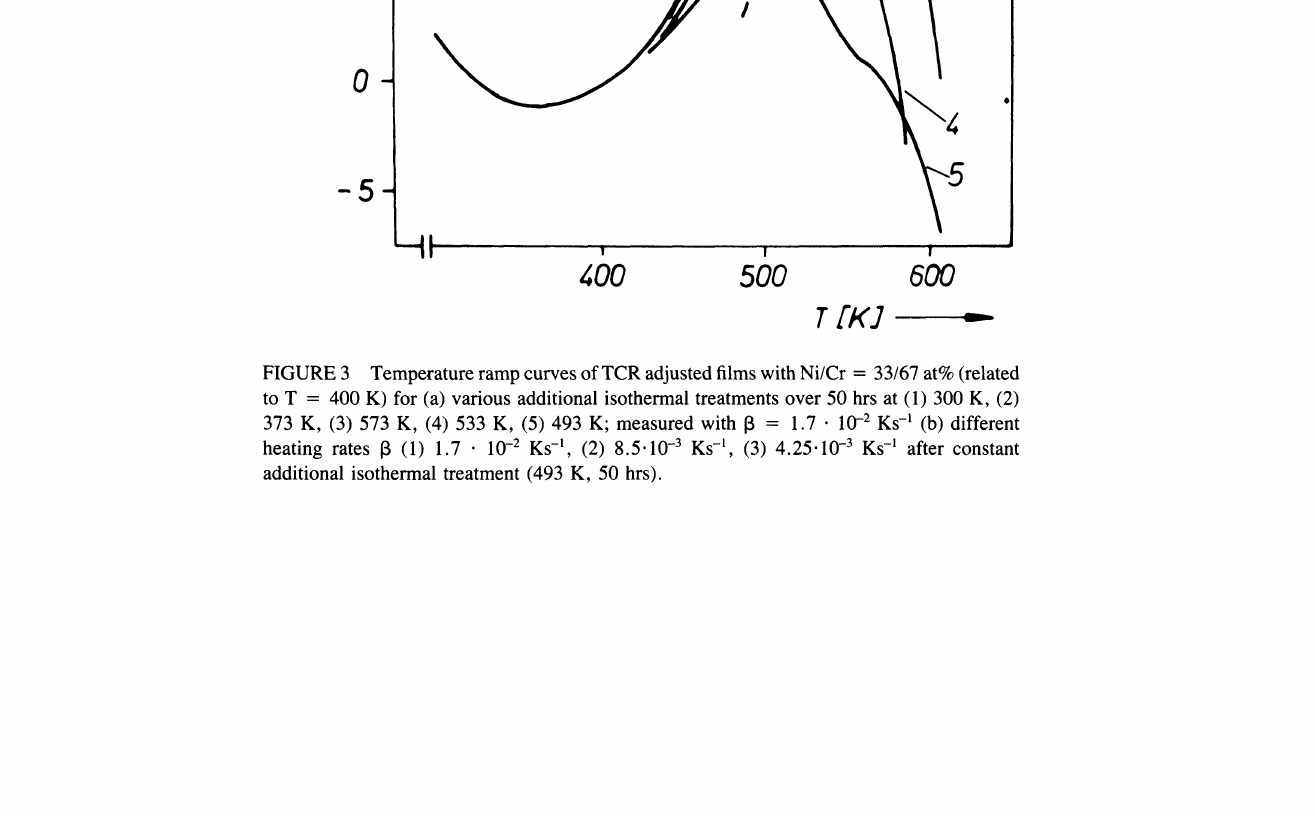
- - (b) different -, -, (2) 8.5.10 -3 Ks (3) 4.25.10 -3 Ks after constant